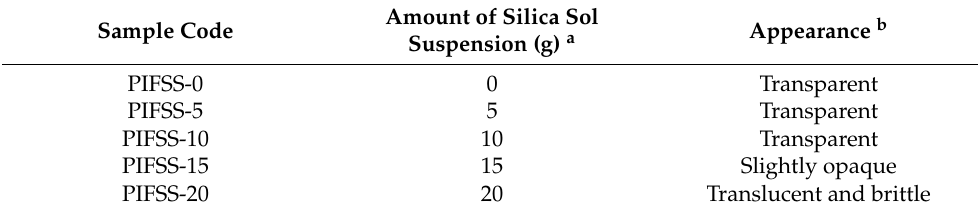
Table 1. Polyimide-fluorinated silica sol (PIFSS) coatings and their appearance.